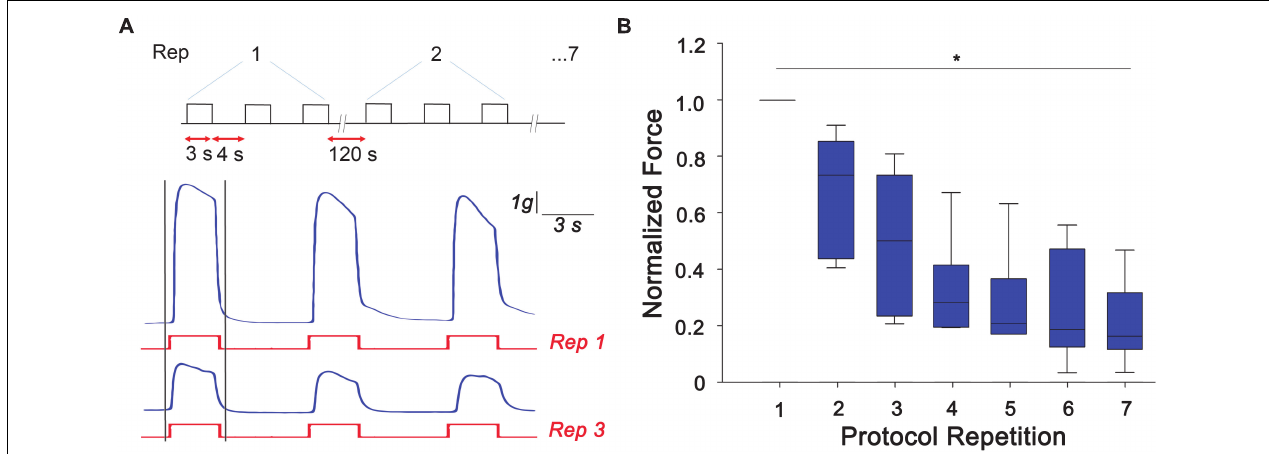
FIGURE 2 | Muscle fatigue induction. (A) Resistance exercise (RE) protocol designed to induce muscle fatigue response consisting of three tetanic stimulation (pulse width: 0.2 ms negative; pulse frequency: 100 Hz; train duration: 3 s), 4 s rest each, repeated 7 times with a rest of 120 s. Exemplary traces of force produced (in blue) at the first (Rep 1) and third (Rep 3) stimulus (in red). Peak tetanic force has been analyzed for the first tetanus of each repetition (highlighted with gray bars). (B) Peak tetanic force, normalized to the maximum peak tetanic force developed by each sample, recorded during the first tetanus of each repetition (Kruskal-Wallis One Way Analysis of Variance, ∗ P < 0.05; n = 6).